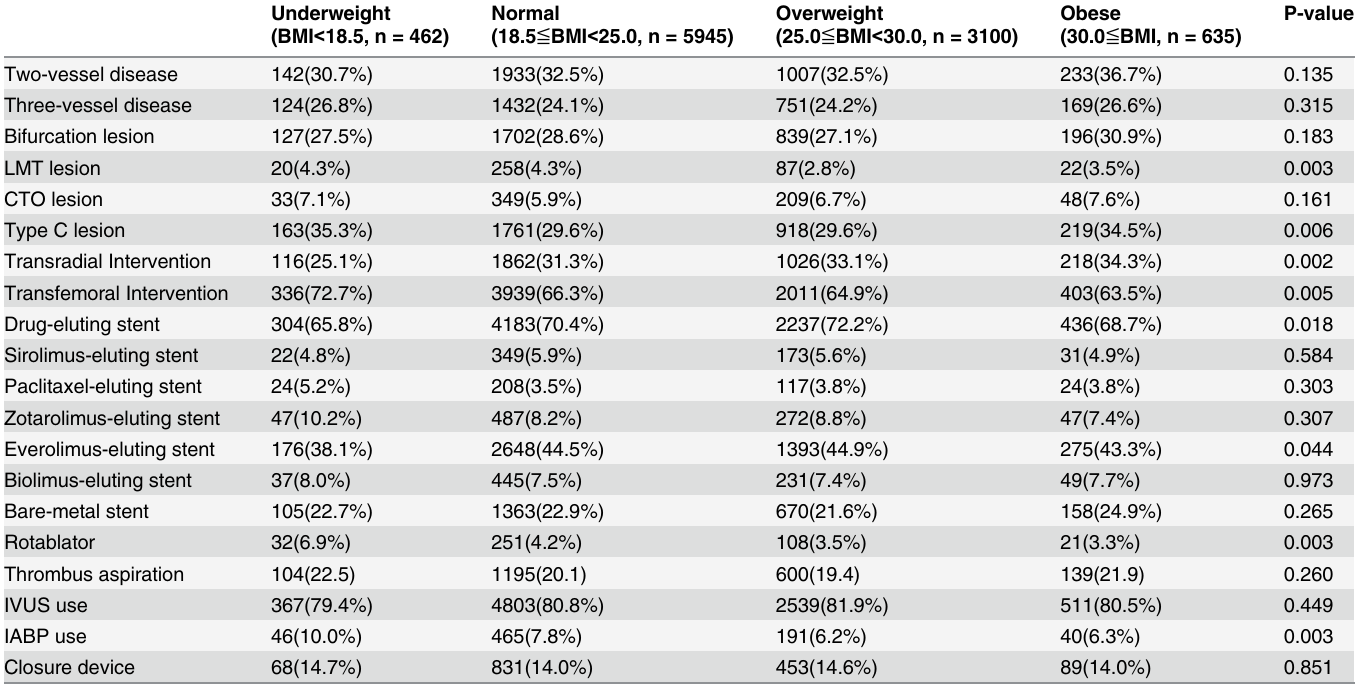
Table 2. Angiographical and Procedural